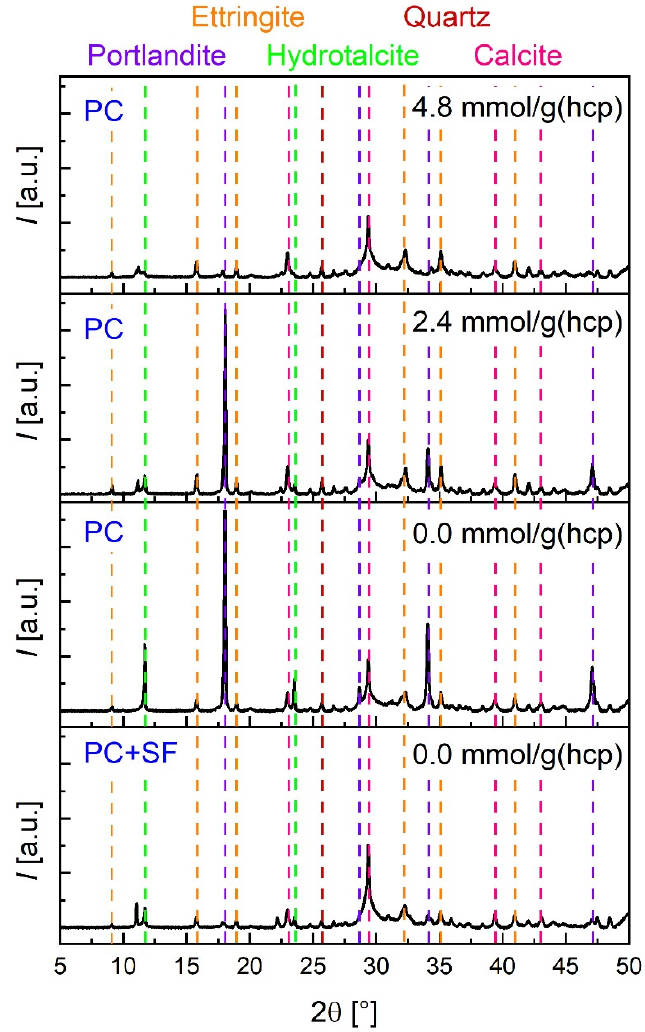
Figure 8. X-ray diffraction patterns of hardened cement paste with and without silica fume after leaching with water and acetic acid. Portlandite is only detectable for the sample without silica fume for the concentrations 0.0 and 2.4 mmol/g ( hcp ) .